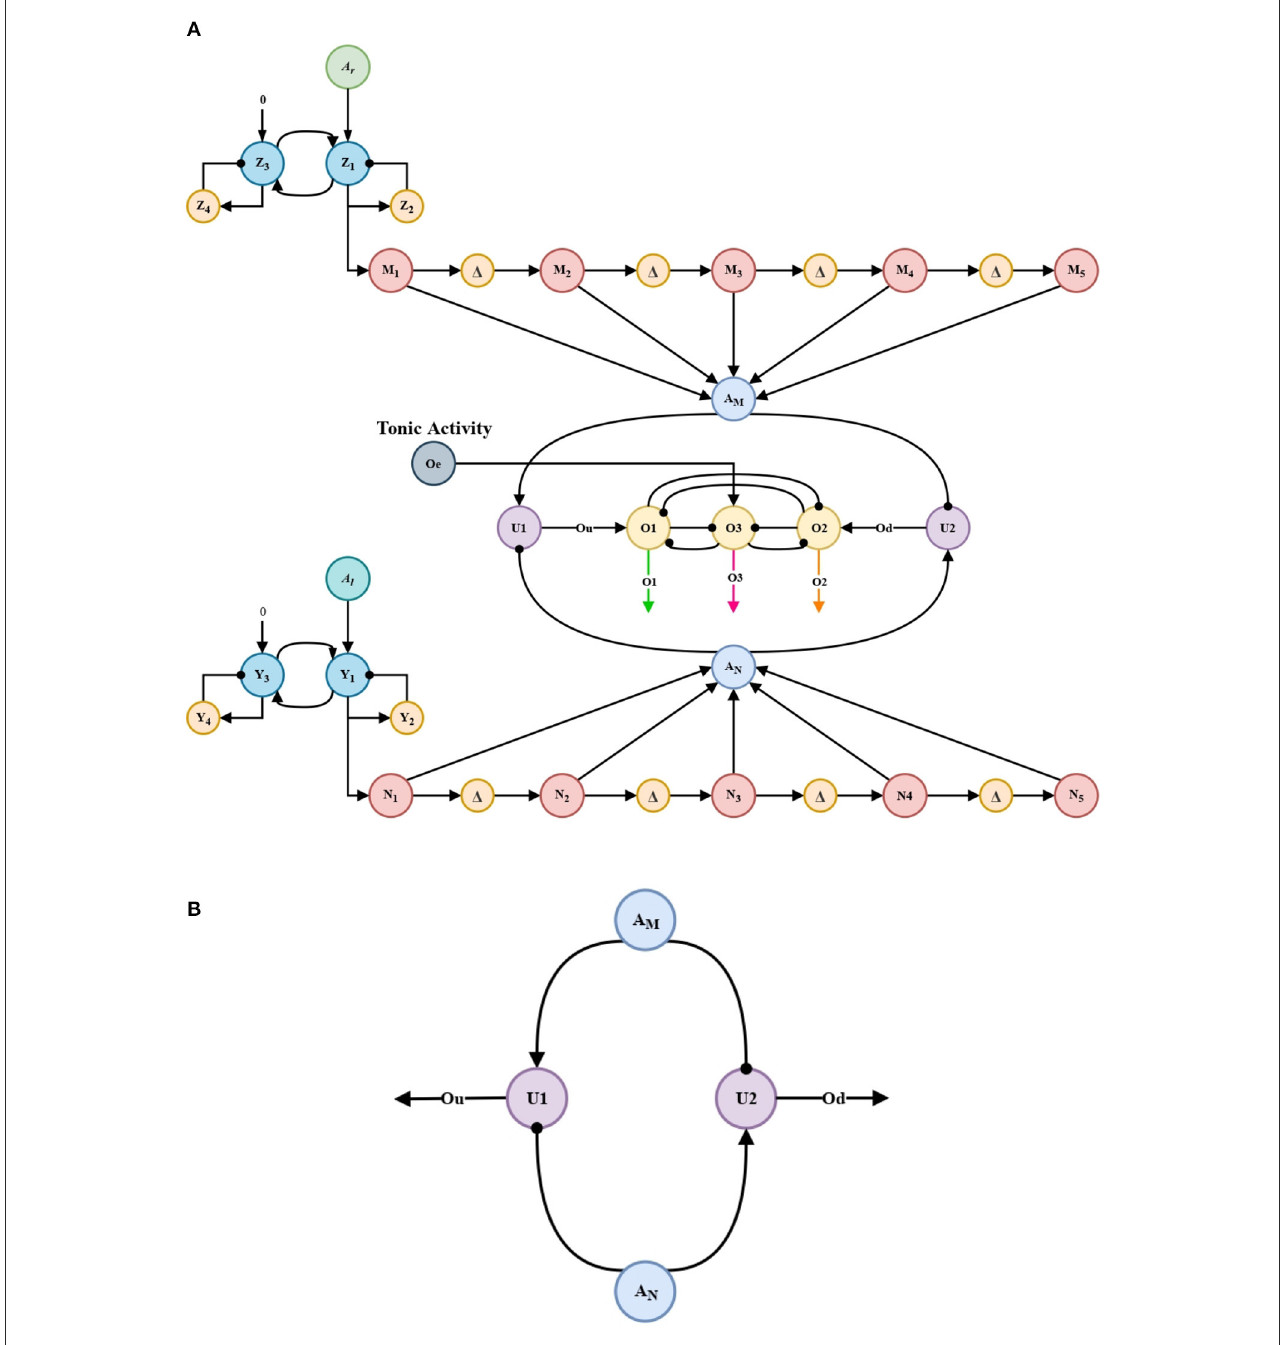
FIGURE4 Architecture of the bio-inspired network for the exploration behavior. (A) Architecture of the bio-inspired network for the exploration behavior. (B) comparison circuit.